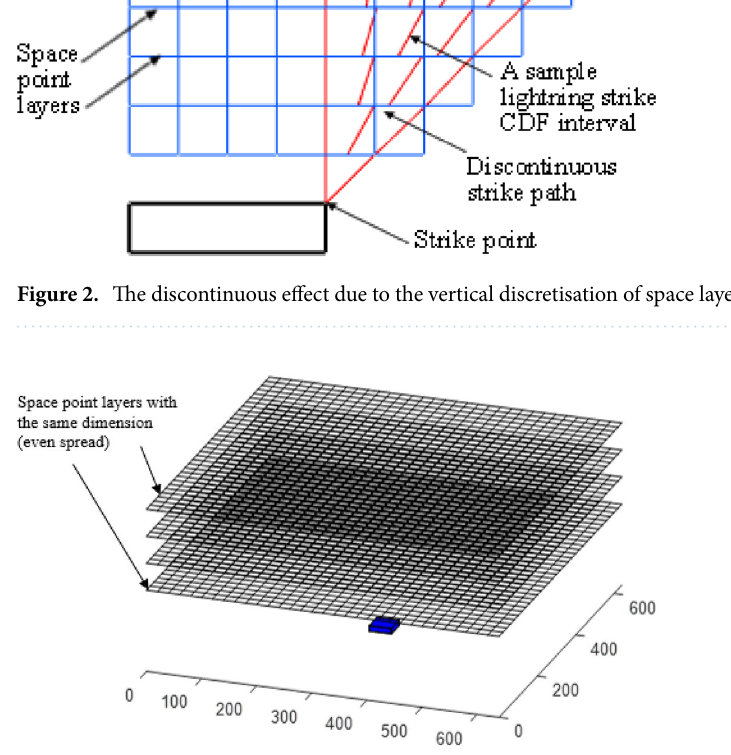
Figure 3. Space point layers evenly spread over the structure 19